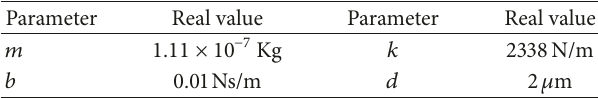
Table 1: Main parameters of tunable capacitor of the MEMS AC voltage